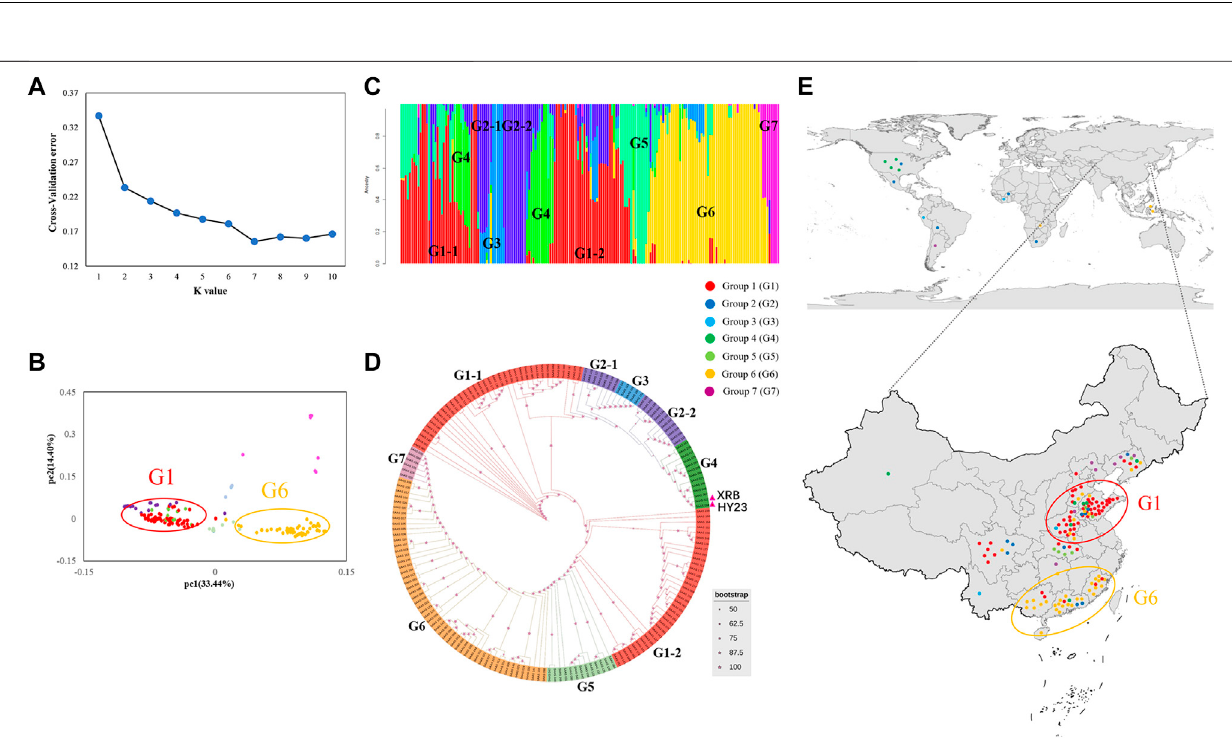
Frontiers in Genetics |